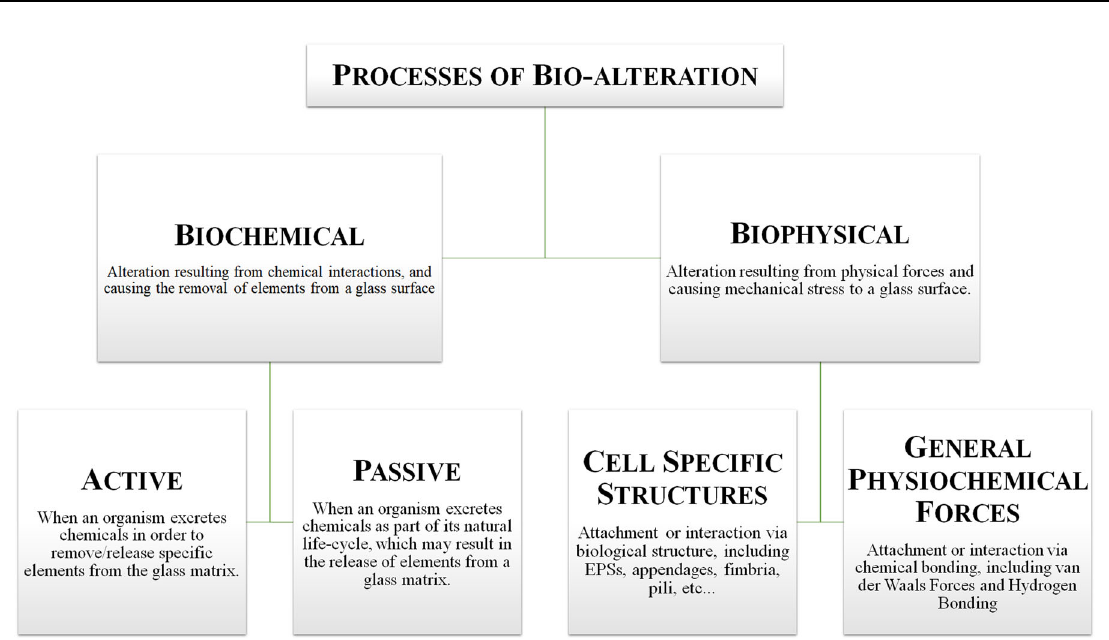
Fig. 4 Outline of processes of bio-alteration. Hierarchial organization of general factors of silicate glass bio-alteration. Although discussed seperately here, biochemical and biophysical processes are most likely synergistic in